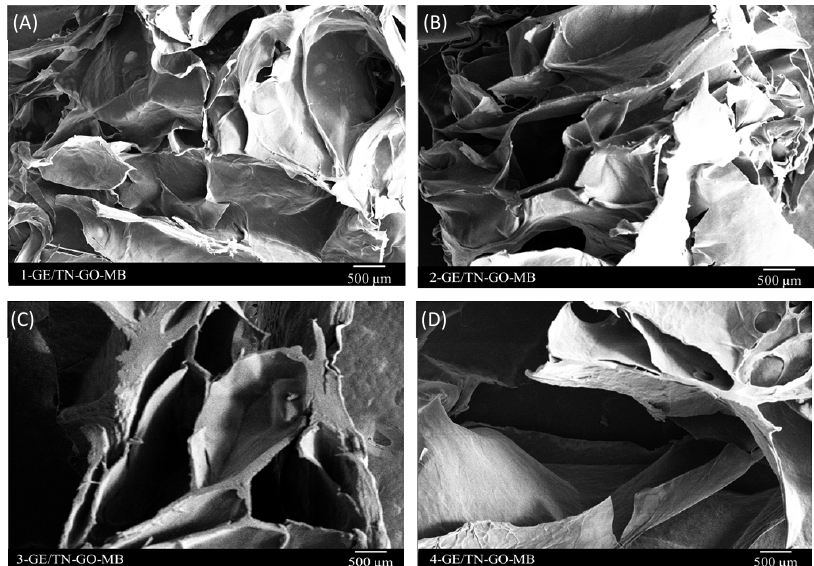
Figure 6. SEM images of the GE/TN-GO-MB hydrogels. ( A ) 1-GE/TN-GO-MB; ( B ) 2-GE/TN-GO- MB; ( C ) 3-GE/TN-GO-MB; and ( D ) 4-GE/TN-GO-MB.